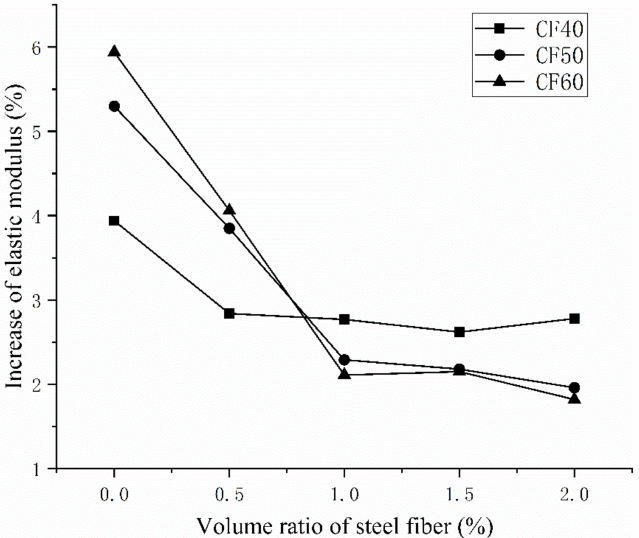
Figure 8. The improvement of the elastic modulus of vibrating mixing concrete compared with ordinary